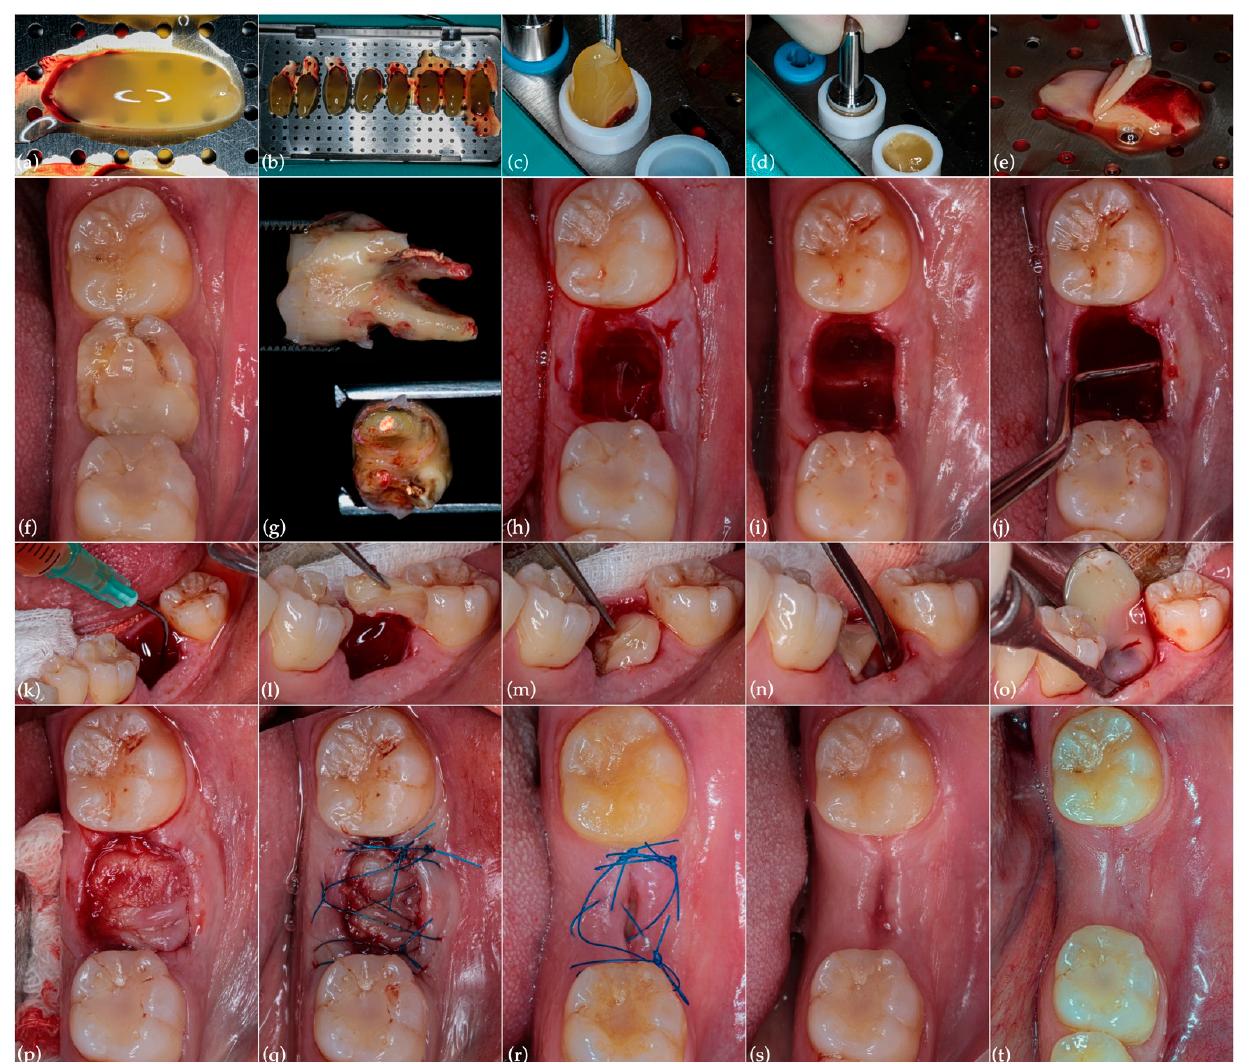
Figure 3. Extraction and alveolar ridge preservation procedures and postoperative controls: (a, b ) L- PRF membranes and ( c , d ) plug preparation; ( e ) double L-PRF membrane; ( f ) preoperative